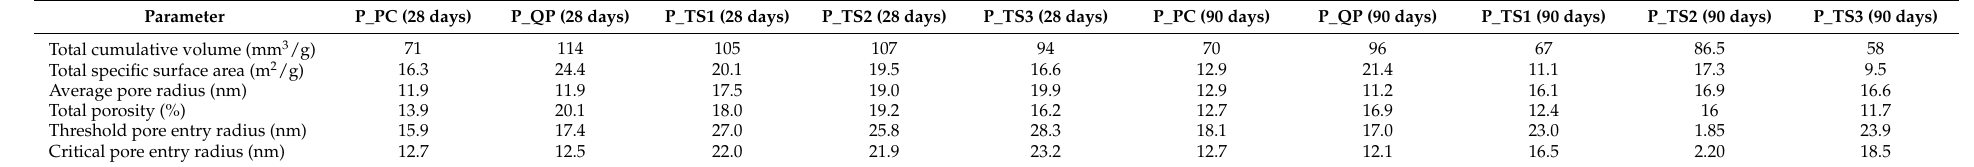
Table 8. Characteristic pore structure parameters of the hardened paste mixtures at 28 and 90